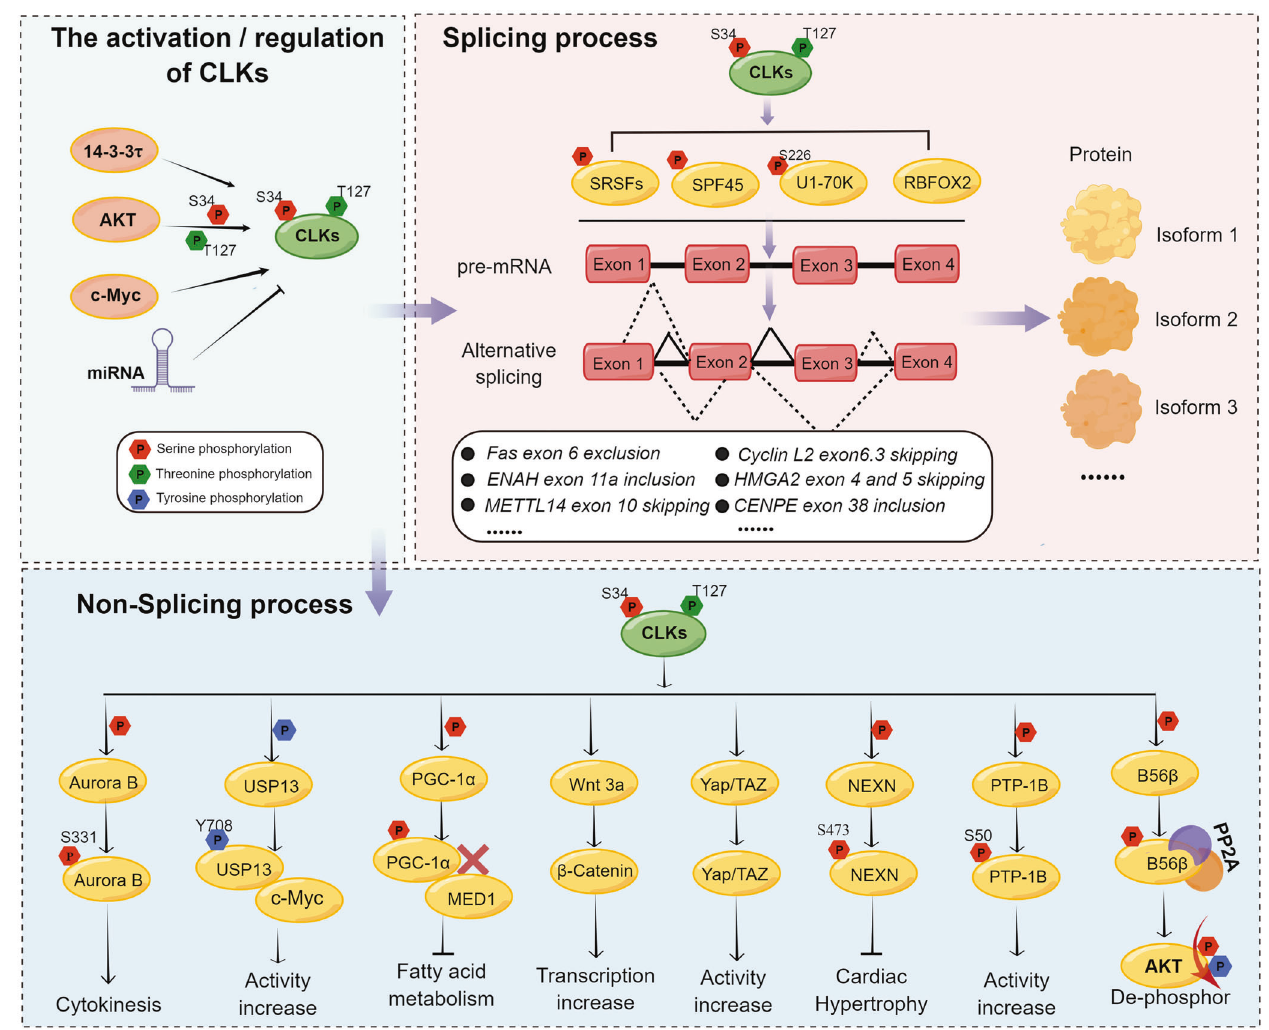
Fig. 2 Biology function of CLKs. CLKs participate in biological processes by modulating splicing and non-splicing functions. CLKs are activated, phosphorylated or regulated by c-Myc, AKT or 14 – 3 – 3 τ , or negatively regulated by miRNAs. CLKs affect their downstream effectors by phosphorylating serine, threonine, or tyrosine residues to activate cellular splicing and non-splicing processes. Alternative splicing of certain genes is increased in response to protein phosphorylation by CLKs. Targets of CLKs include SR proteins, SPF45, and/or U1 – 70K or modulated RBFOX2. Consequently, different protein isoforms that function in multiple cellular processes are generated. CLKs promote cytokinesis, increase c-myc activity, and suppress fatty acid metabolism by phosphorylating downstream Aurora B, USP13, and PGC-1 α . The activation of Wnt/ β -catenin and Hippo signaling by increased expression of Wnt 3a or YAP further highlights the importance of CLKs in non- splicing processes. The fi gure was generated using Figdraw (www. fi phosphorylated SPF45 at eight different Ser residues, facilitating cell migration and invasion in a phosphorylation-dependent manner on SKOV-3 cells. Furthermore, CLK1 enhanced SPF45- induced Fa s mRNA exon 6 exclusion to facilitate serum-stimulated cell migration, whereas inhibition of CLK1 promoted SPF45 degradation and inhibited a proteasome-dependent manner. 46 CLK1 was reported to phos- phorylate U1 – 70K at the C-terminal Ser226 residue, facilitating U1 – 70K release from subnuclear granules and its subsequent interaction with U1 snRNP and SRSF1 for early spliceosomal protein assembly. 48 Furthermore, SR protein kinase 1 (SRPK1) dissociated CLK1 from U1 – 70K to recycle kinase catalysis. 48 Elevated CLK2 mRNA levels were observed in luminal and HER2 + breast cancer cell lines as well as the EGFR-ampli fi ed MDA-MB-468 and EGF-dependent MCF10DCIS triple-negative breast cancer (TNBC) cell lines. CLK2 promoted the inclusion skipping at exon 11a of mesenchymal-type ENAH in luminal breast cancer cells through the modulation of RBFOX2 as opposed to